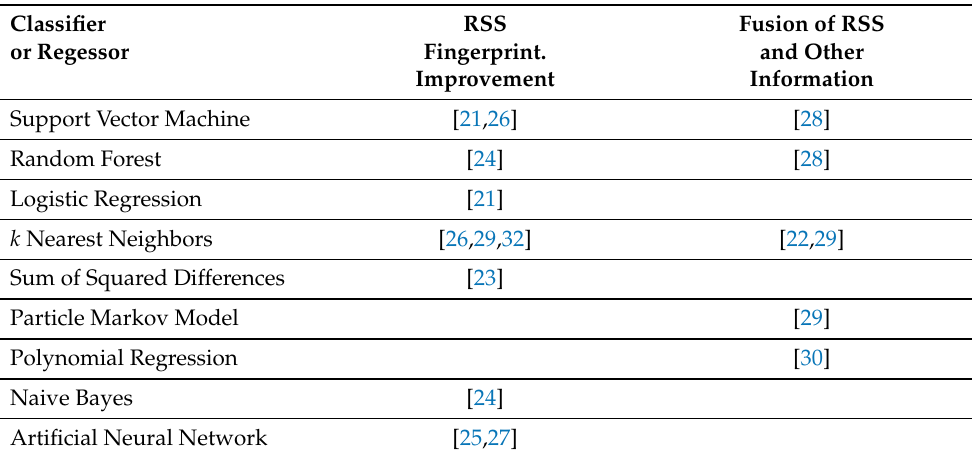
Table 1. Summary of literature considering Machine Learning for localization algorithm improvement and data fusion in the context of RSS localization.